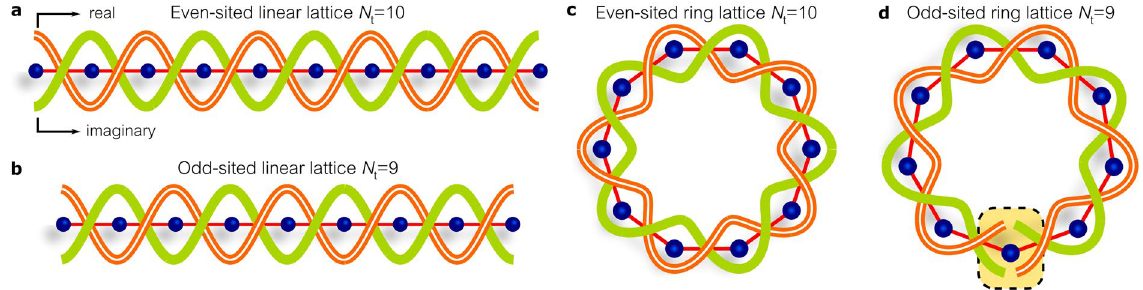
Figure 2. Braiding of the real and imaginary field components around linear and ring lattices endowed with chiral symmetry. ( a , b ) Braiding the real and imaginary field components along linear lattices is insensitive to the lattice parity–whether ( a ) even-sited or ( b ) odd-sited–due to the free lattice boundaries. ( c ) Braiding is complete around an even-sited ring lattice. ( d ) Braiding cannot be completed around an odd-sited ring lattice. Incommensurability breaks the chiral